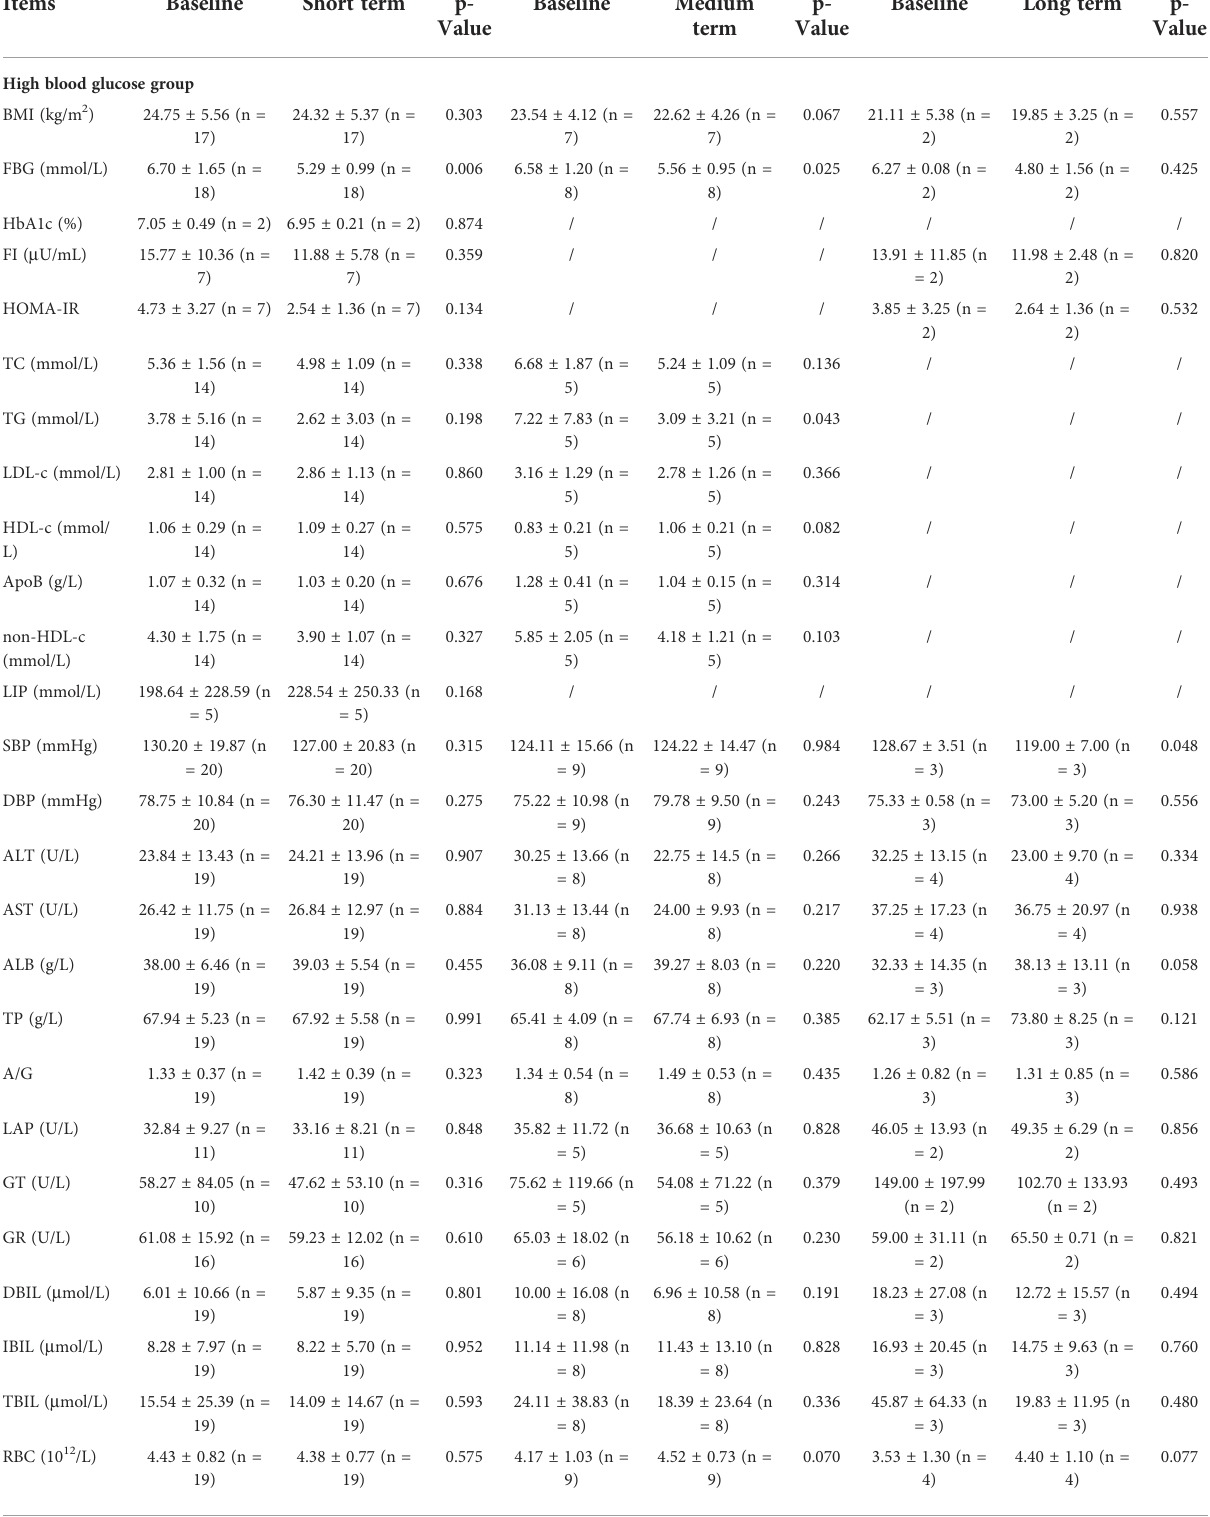
TABLE 3 The comparison values of each index in high blood glucose group and normal blood glucose group in the short term, medium term and long term with baseline during the treatment of washed microbiota transplantation.